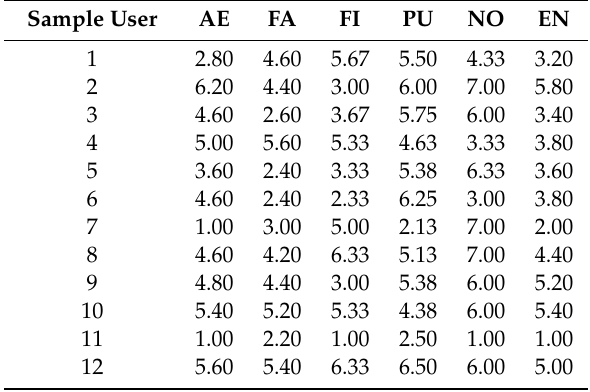
Table 2. UES questionnaire results. Abbreviations for sub-scales are used: AE = aesthetics, FA = focused attention, FI = felt involvement, PU = perceived usability, NO = novelty, EN =